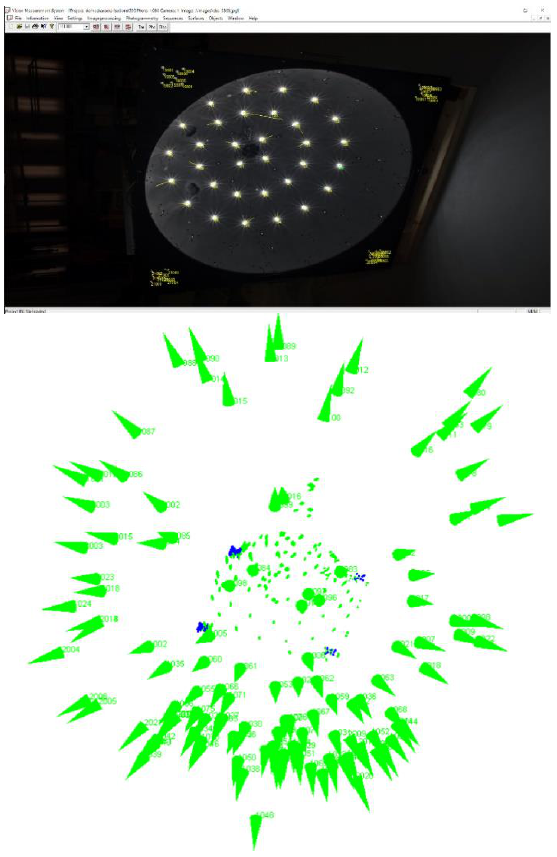
Figure 3. (Top) Example image combining dome light sources and targets. (Bottom) Photogrammetric network used to characterise the imaging dome and its lighting